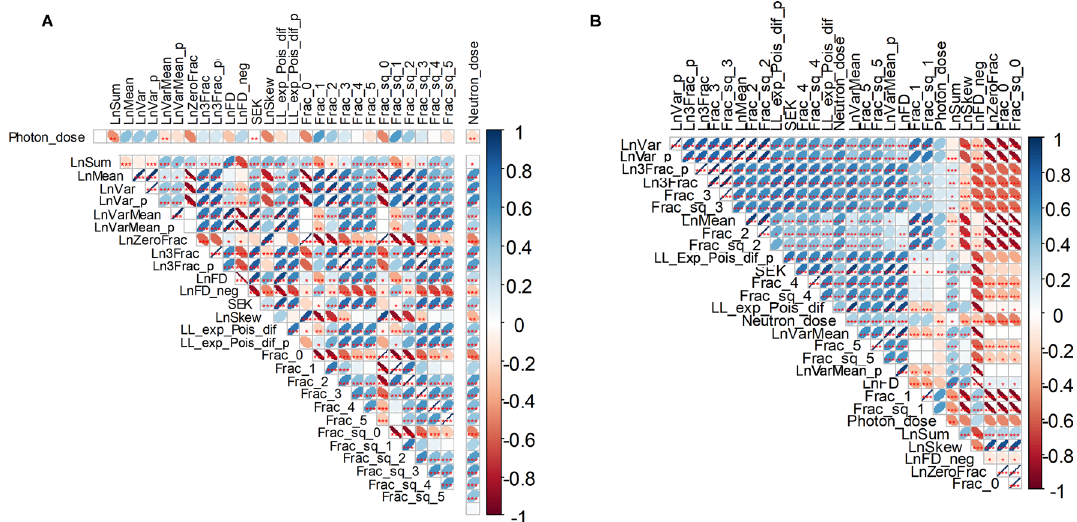
Figure 3. Matrix of Spearman’s correlation coefficients between all variables in the analyzed training data set. The meanings of all variables are provided in Table 1, and a color-coded correlation scale is provided on the right of the plot. Blue ellipses represent positive correlations, and red ones represent negative correlations. Darker color tones and narrower ellipses represent larger correlation coefficient magnitudes. Red star symbols indicate statistical significance levels: ***indicates p < 0.001, **indicates p < 0.01, *indicates p < 0.05, no stars indicate p > 0.05. These p-values here are intended only for visualization: since the correlations are pairwise, without correction for multiple testing, only 3-star significance levels are likely to indicate strong associations. Blank squares indicate correlation coefficients close to zero. ( A ) Default ordering of variables with photon and neutron doses in the top rows. ( B ) Ordering of variables by similar correlation coefficients to show variable